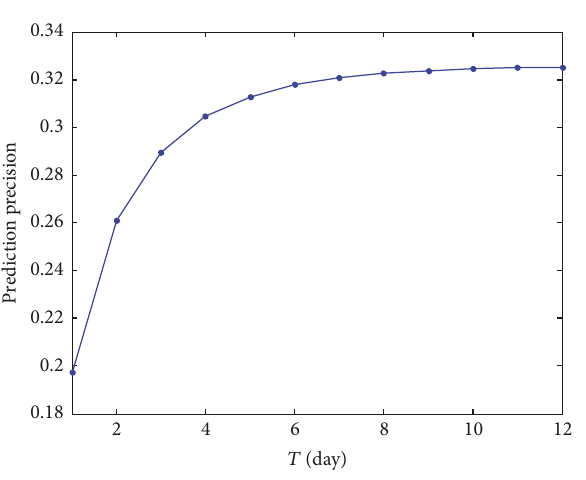
Figure 11: Cumulative Bayesian factors of